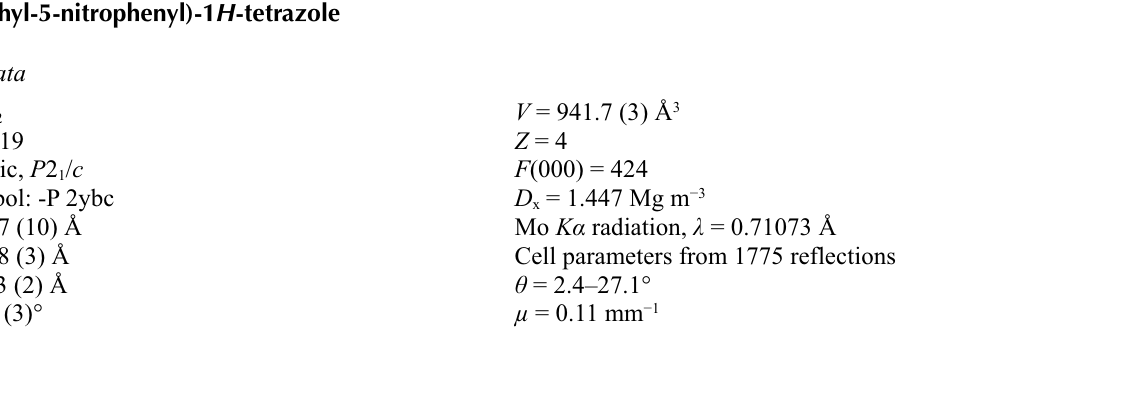
Part of the crystal packing of the title compound, showing a hydrogen- bonded (dashed lines) chain running along the a axis. H atoms not involved in hydrogen bonding have been omitted for